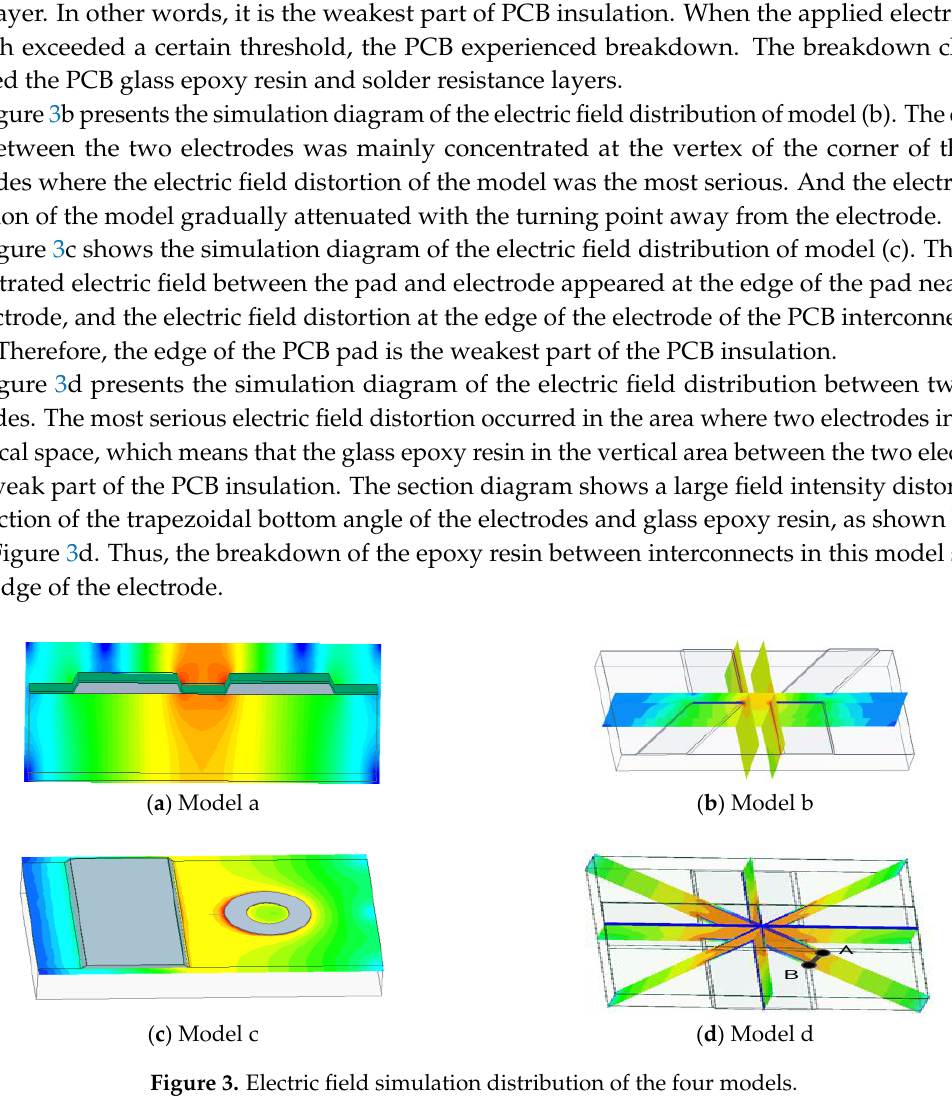
Figure 4. Breakdown test system.